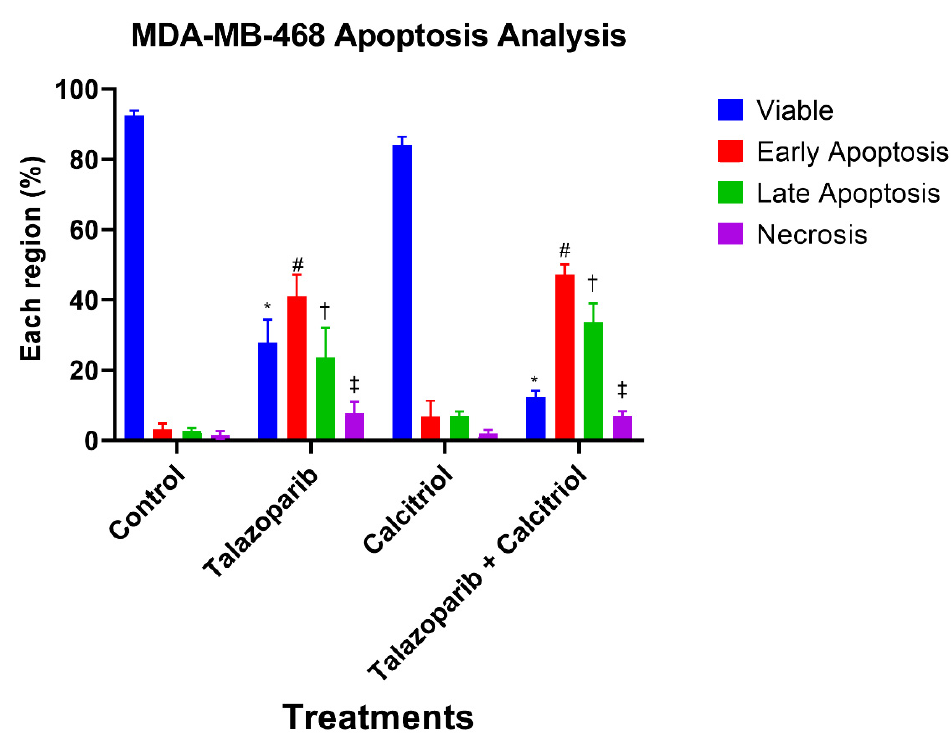
Figure 10. Histogram for apoptosis rate in MDA − MB − 468. Data are represented as means ± SD of three independent experiments where (*) indicates a significant difference of viable cells between treatments versus the control group as * p < 0.05 vs. untreated control. (#) indicates a significant difference of early apoptosis between treatments versus the control group as # p < 0.05. (†) indicates a significant difference of late apoptosis between treatments versus the control group as † p < 0.05. (‡) indicates a significant difference of necrosis between treatments versus control group as ‡ p < 0.05. Data were compared between the untreated control and the treatment groups by a one − way ANOVA post − hoc test (Tukey) using SPSS. Details of statistical analysis can be found in Table